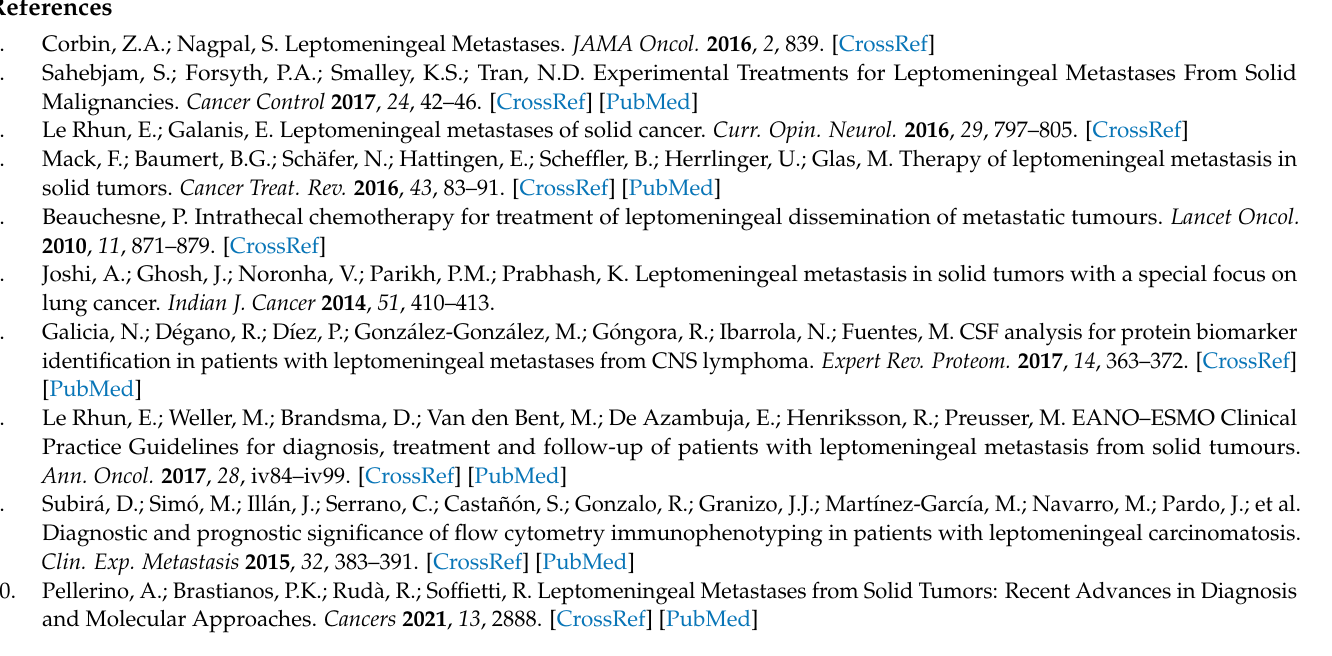
of study. Table S6: Intensity data results from Planar Protein Microarrays. Table S7: Intensity data results from Beads Suspension Microarrays. Table S8: ROC analysis list of potential biomarker panel on CSF +/ − LM and the different comparisons by protein arrays and affinity